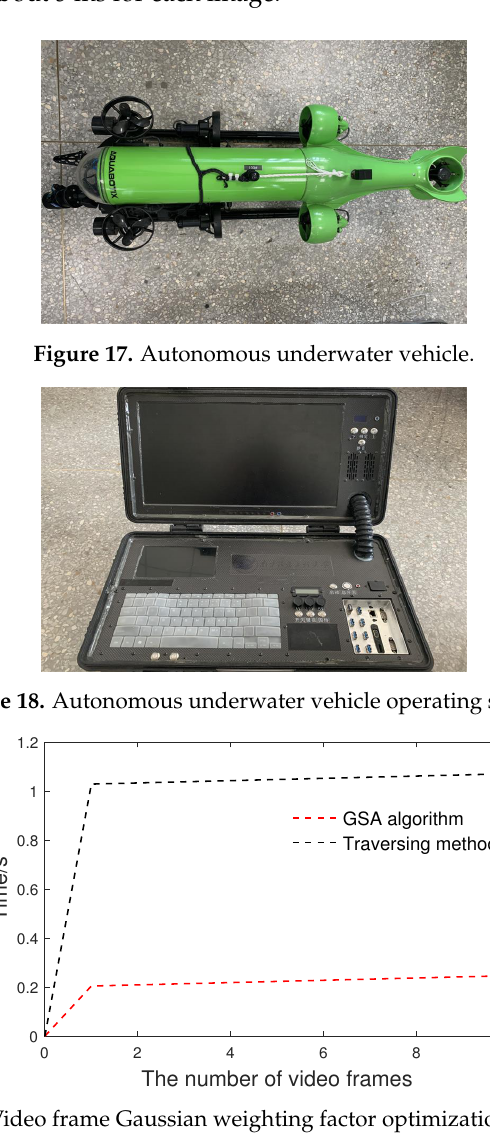
Figure 19. Video frame Gaussian weighting factor optimization time